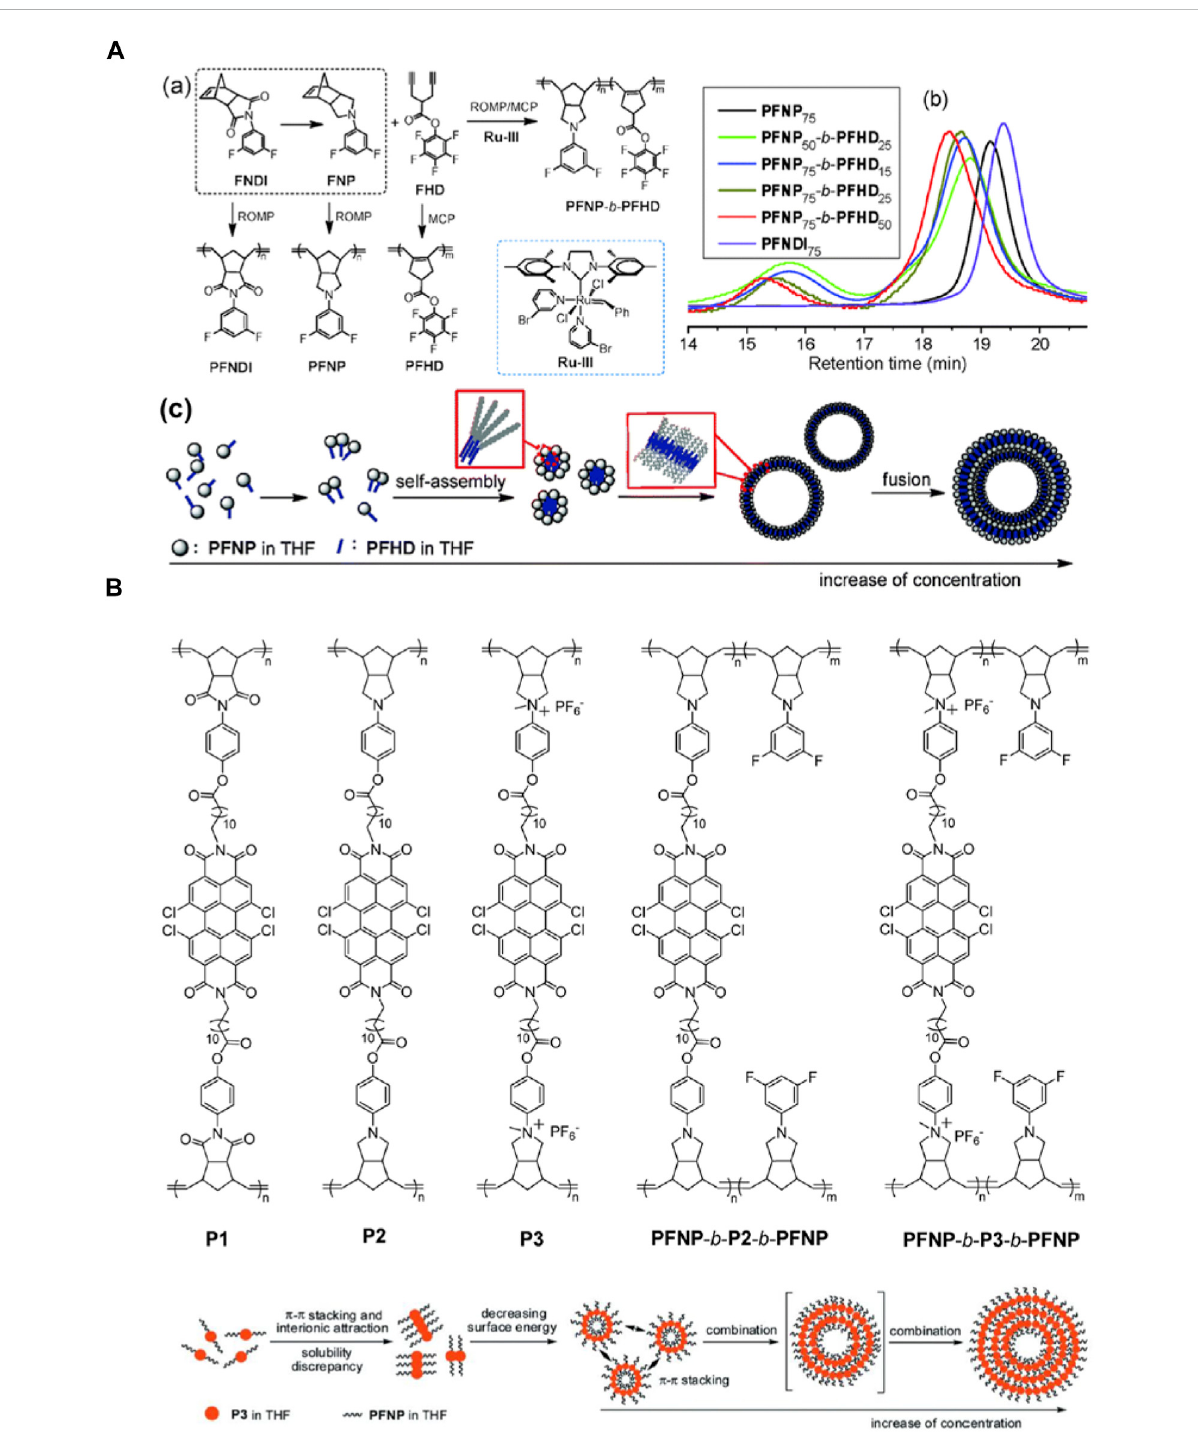
FIGURE 9 (A) Synthetic routes (a) and GPC traces (b) of the homo- and copolymers; (c) the schematic process of hollow sphere nanostructure formation from a single chain of the copolymer in THF; (B) Structure of polymers obtained by ROMP method and the schematic process of a tree ring-like nanostructure by the self-assembly of triblock copolymer in THF. Reproduced with permission from Ref. 80 and 81. Copyright 2015 and 2016 The Royal Society of